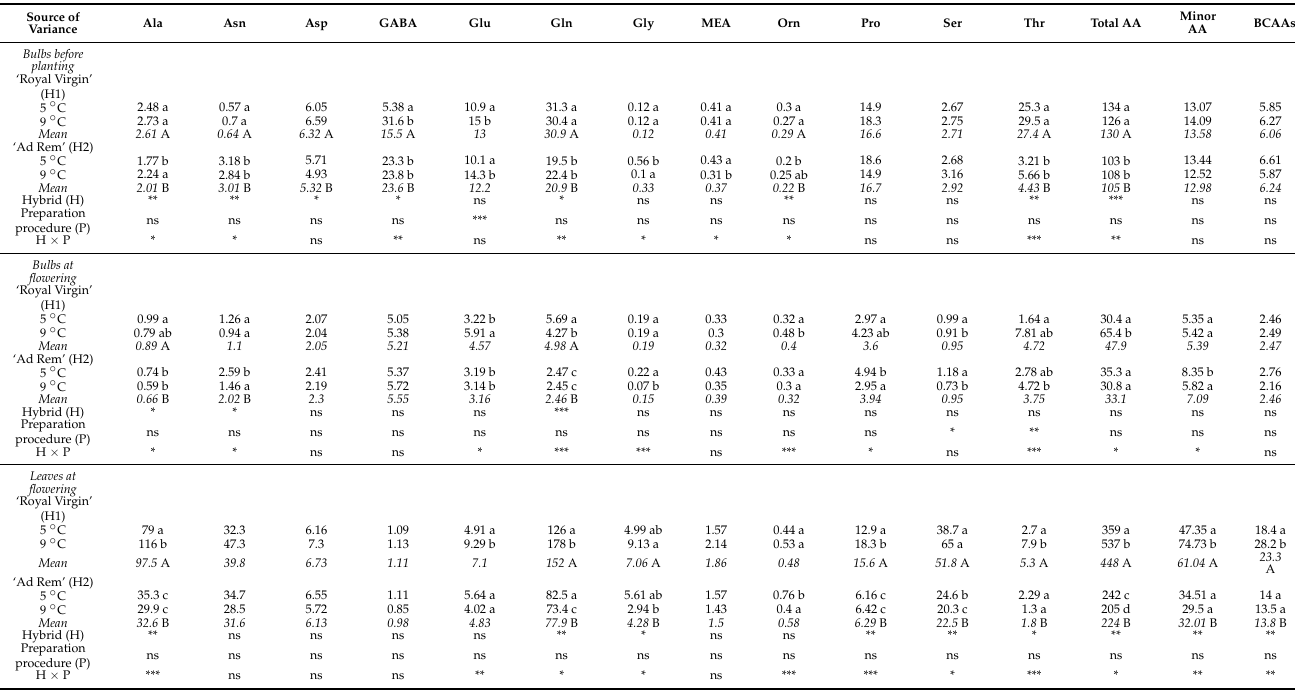
Table 4. Free amino acid content ( µ mol g − 1 DW) in bulbs and leaves of the two hybrids of Tulipa gesneriana L. ‘Royal Virgin’ and ‘Ad Rem’ grown hydroponically from bulbs subjected to two prepa- ration procedures, 9 ◦ C and 5 ◦ C. Alanine (Ala), asparagine (Asn), aspartate (Asp), γ -aminobutyric acid (GABA), glutamate (Glu), glutamine (Gln), Glycine (Gly), monoethanolamine (MEA), ornithine (Orn), proline (Pro), serine (Ser), threonine (thr), total amino acids (Total AA), minor amino acids (minor AA), and branched chain amino acids (BCAAs). ns—nonsignificant; *, **, and ***—significant at p ≤ 0.05, p ≤ 0.01, p ≤ 0.001, respectively. Different lowercase or capital letters within each column, for specific vegetative stage, indicate significant differences ( p = 0.05).